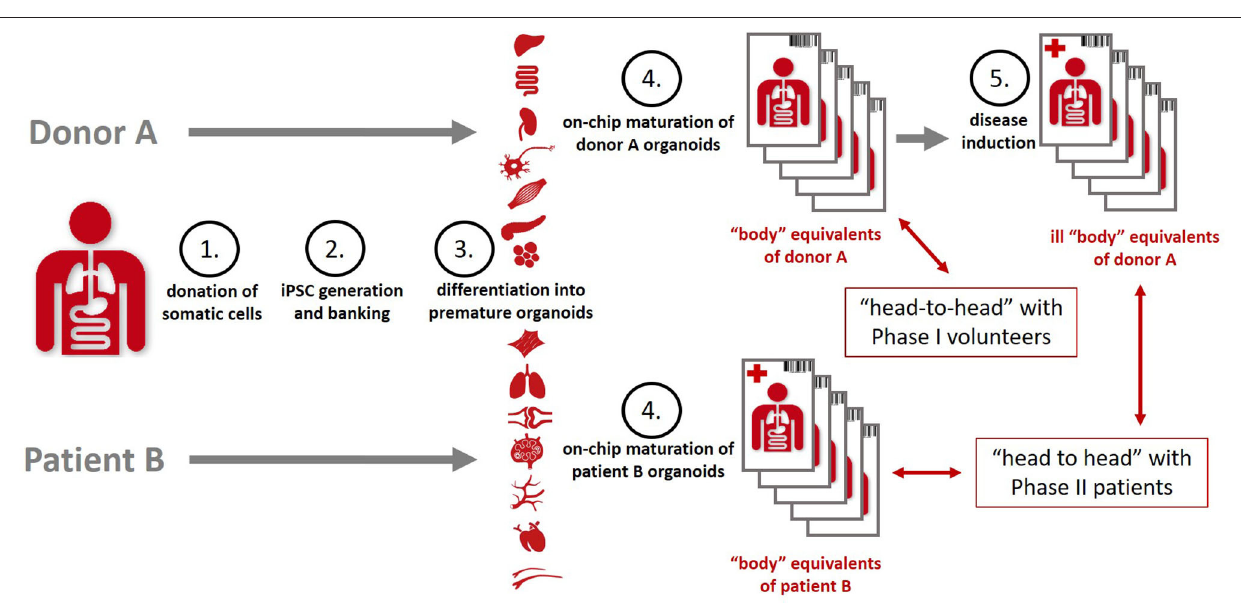
1 and 2 clinical trials (106). An advanced roadmap toward the qualification of the precision of prediction of “clinical trials” ( Figure 6 ) running minute personalized “body” equivalents (organismoids) in on-chip studies head-to-head with clinical